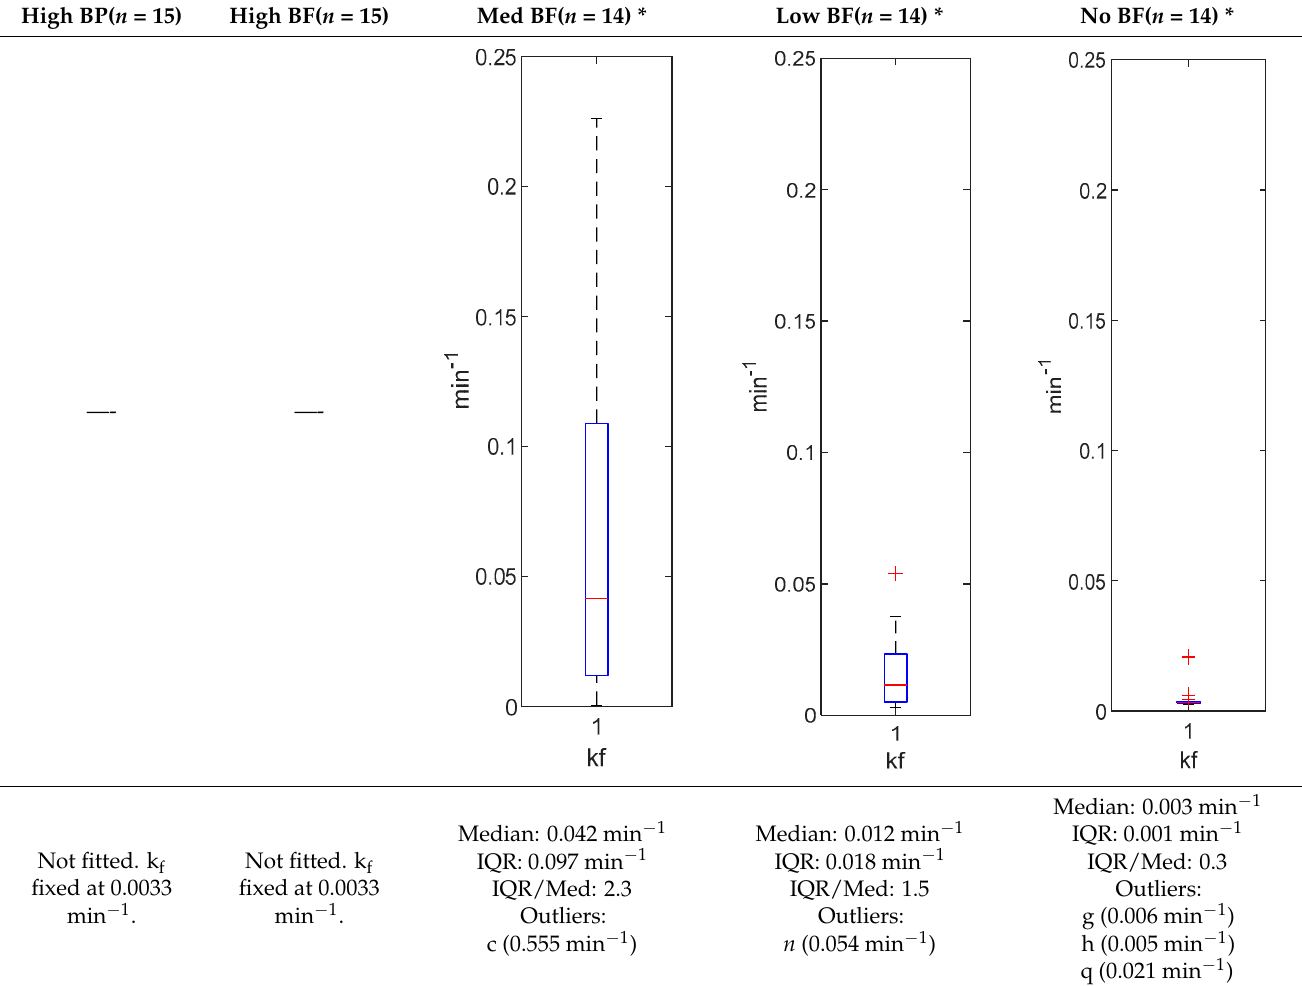
Table 5. k f estimation results (horizontal red bar: median, blue box second and third quartile, whiskers first and fourth quartiles, +: outliers).